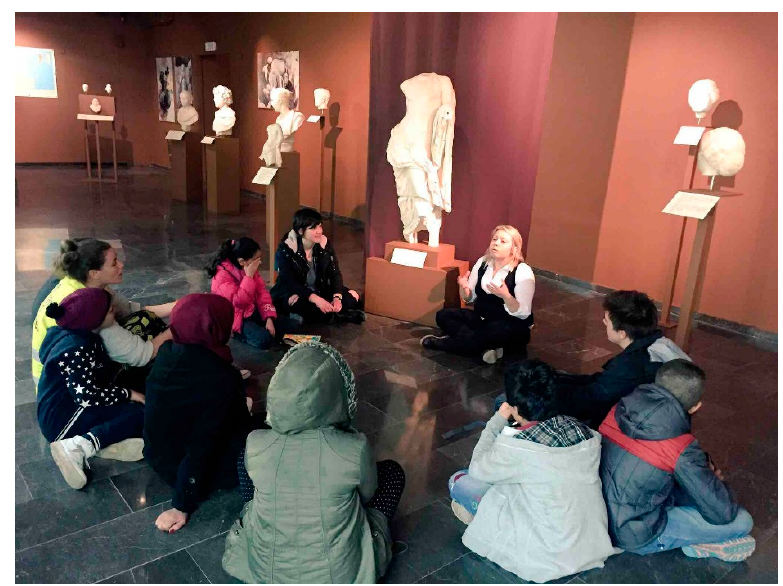
Figure 3. Visiting the Chios Archaeological Museum. Photo by author.